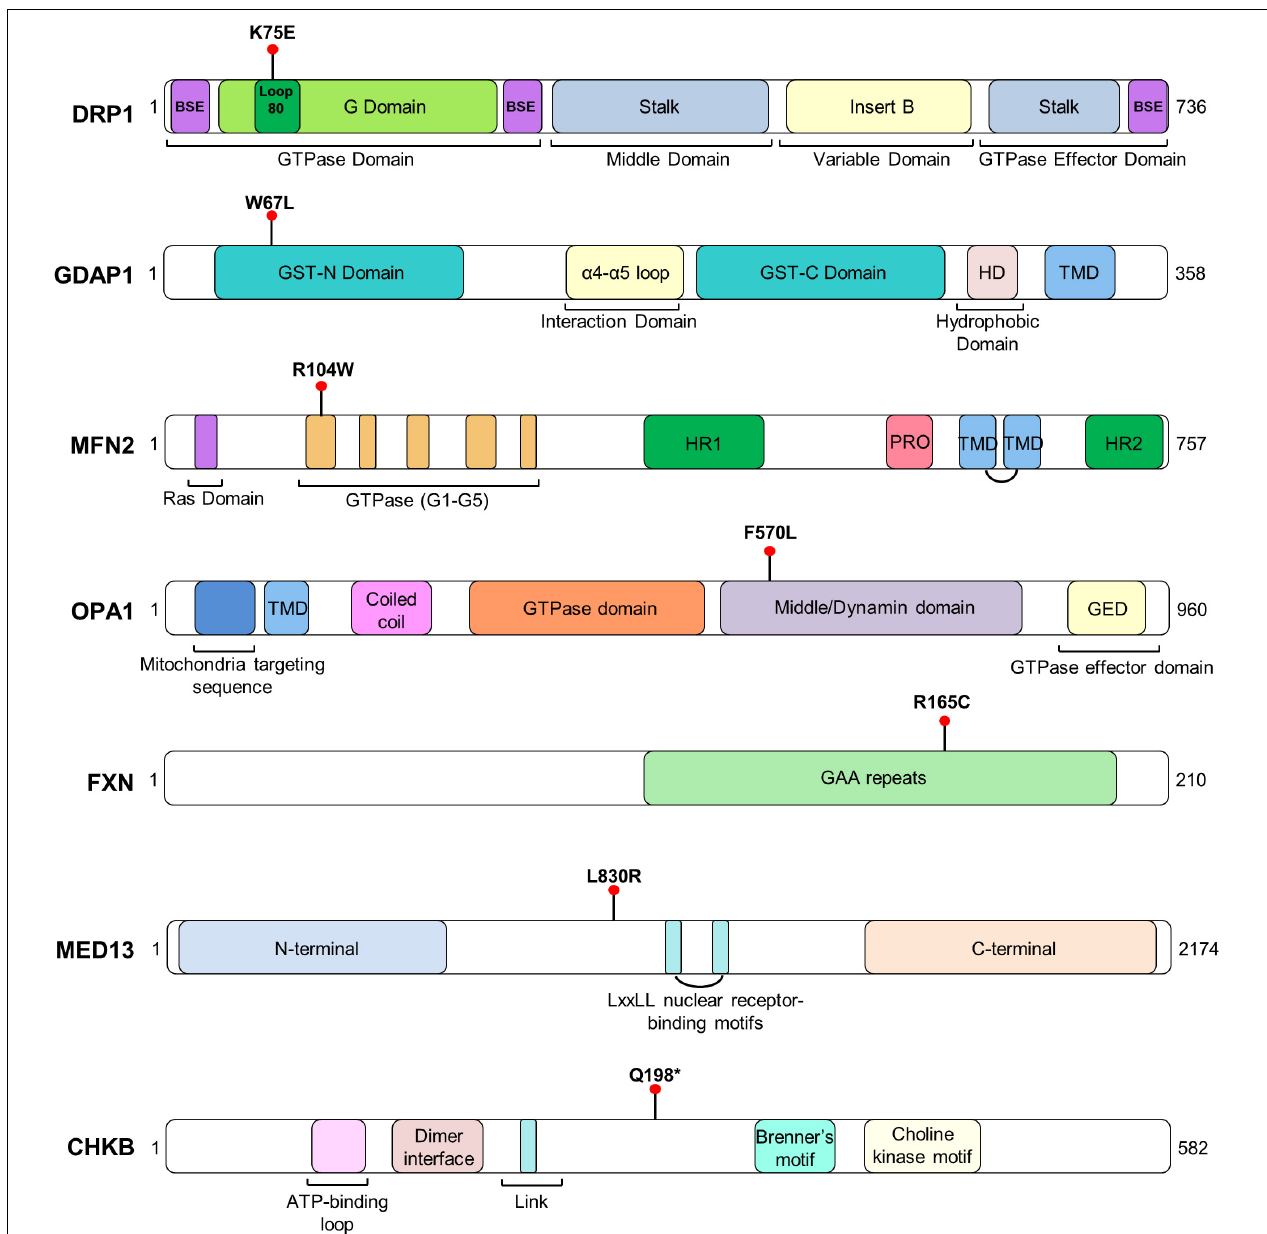
FIGURE 1 | Representative scheme of the domains and structure of each protein with the location of patients’ variants. TM, transmembrane